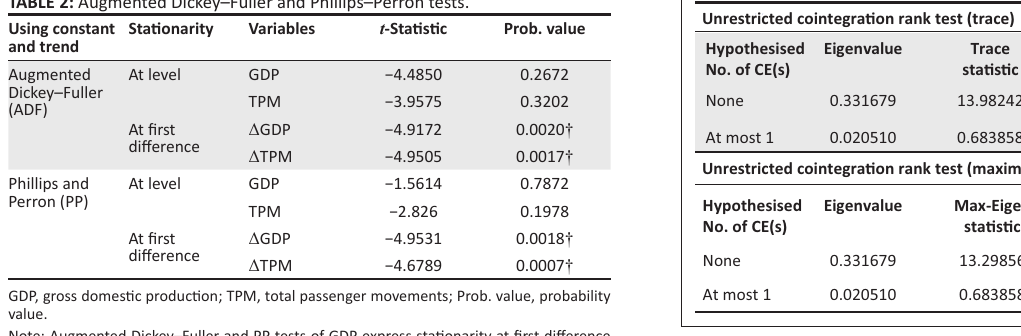
FIGURE 2: Johansen–Juselius likelihood cointegration